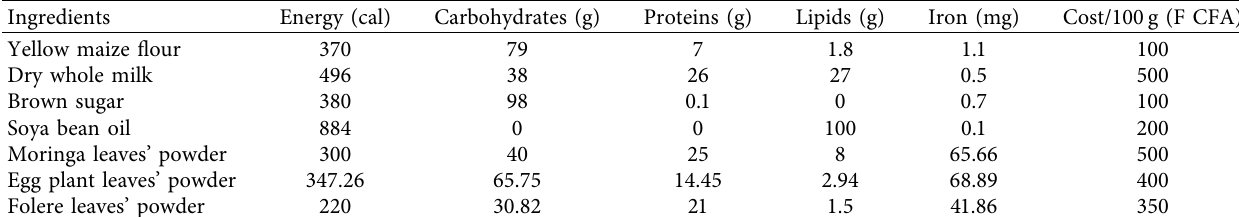
Table 1: Food composition for 100g and cost of the ingredients used to develop the 3 formulated flours.